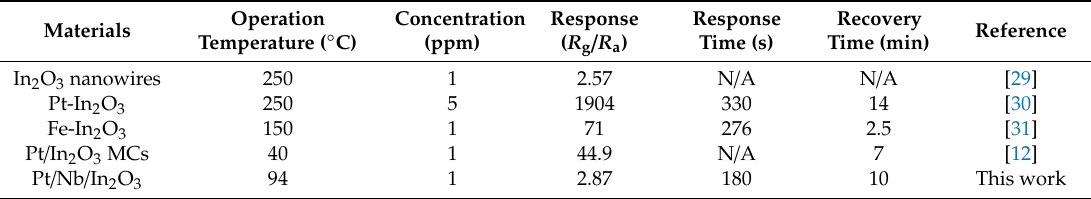
Table 1. Comparison of the sensing performance of various NO 2 gas sensors based on In 2 O 3 .